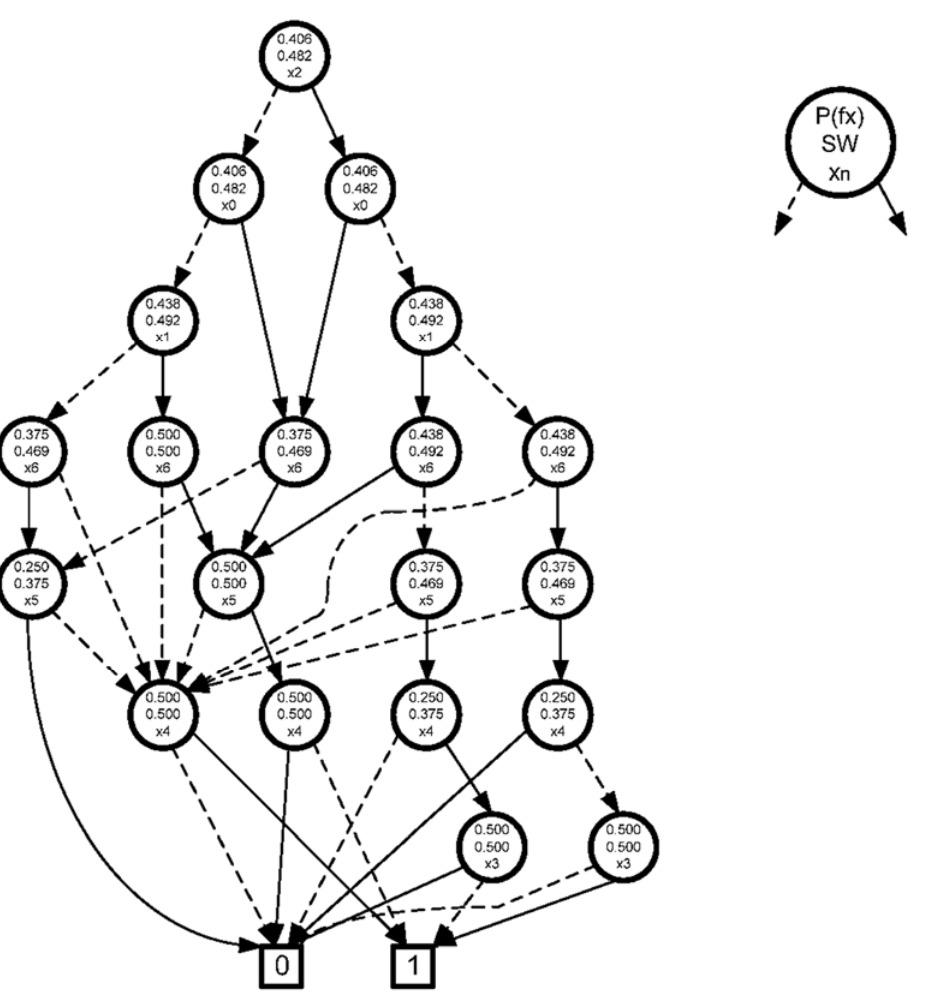
Figure 4. SWBDD diagram.